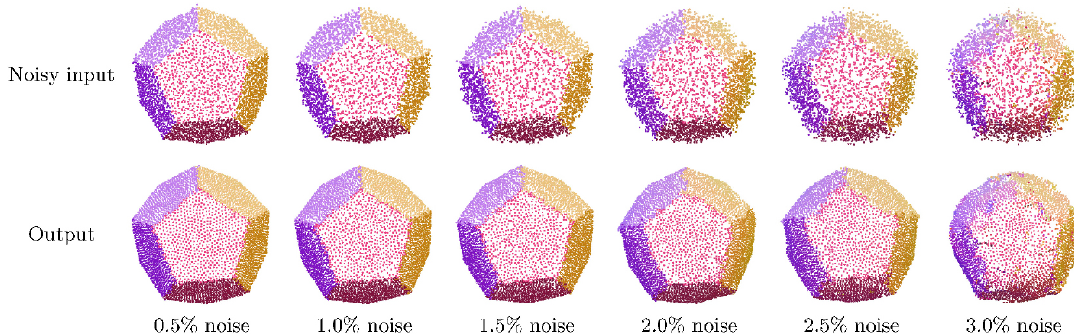
Fig. 18 Filtered results for models with different levels of